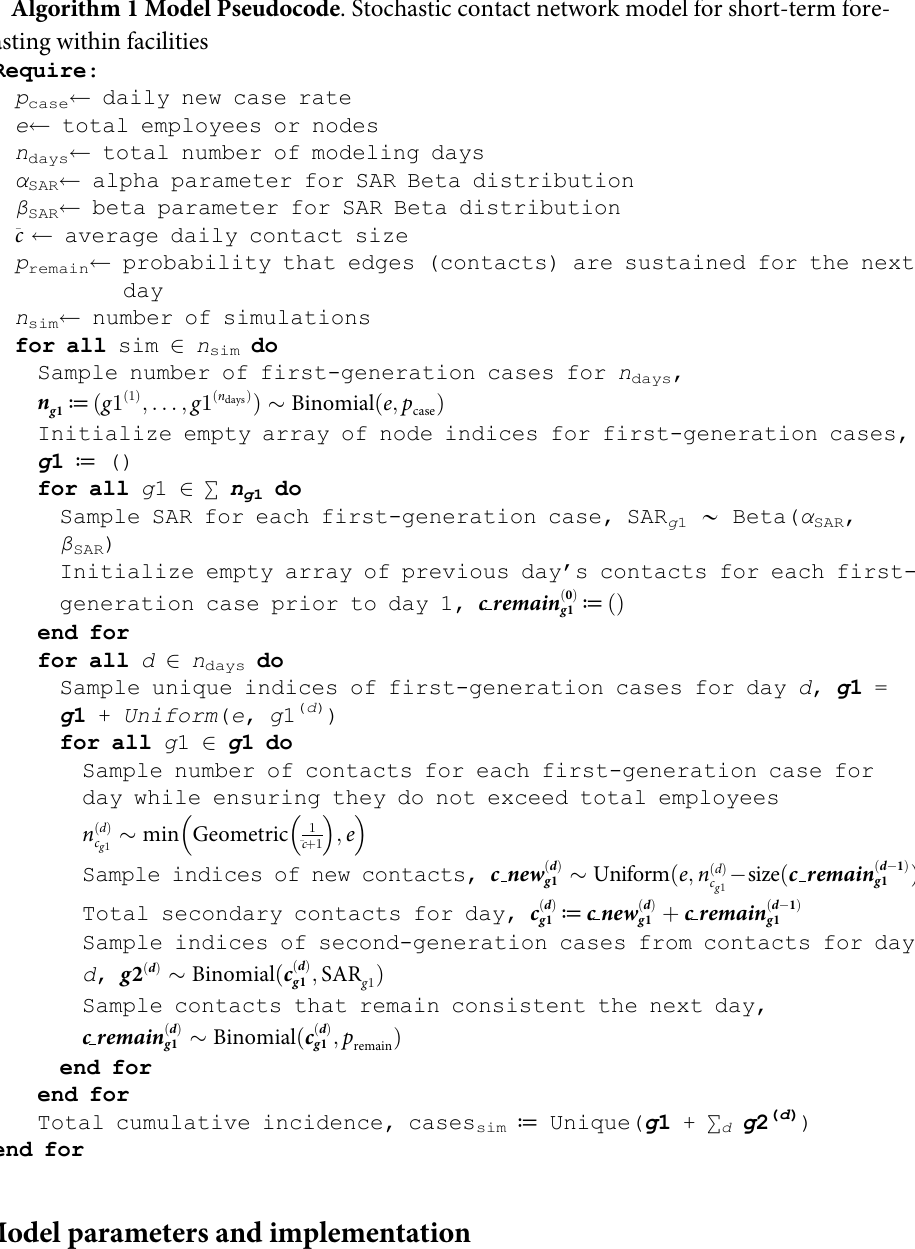
Algorithm 1 Model Pseudocode . Stochastic contact network model for short-term